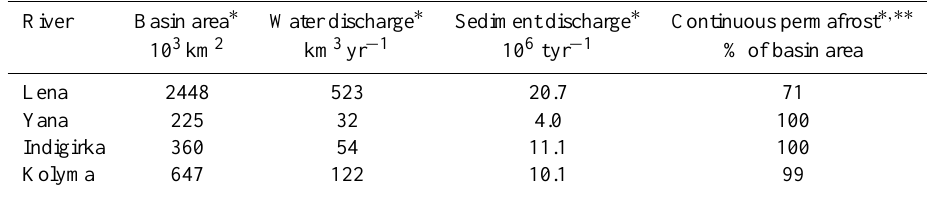
Table 1. Physical properties of major rivers draining East